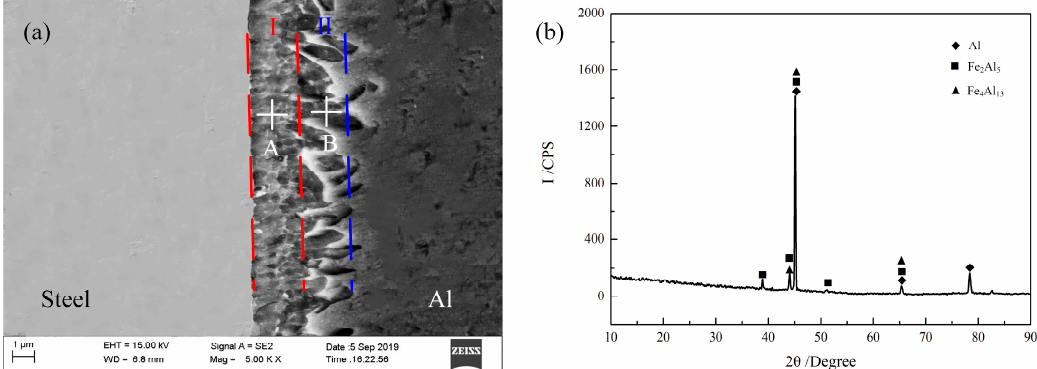
Figure 9. Microstructure and XRD results of the intermetallic compounds (IMCs) layer (laser power